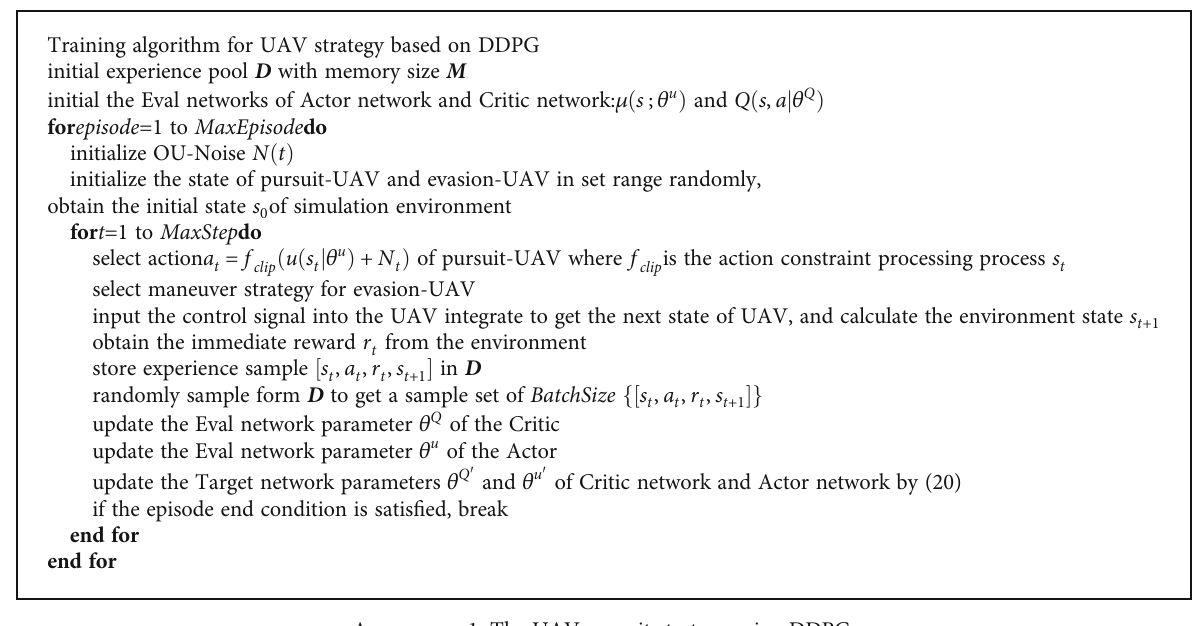
Algorithm 1: The UAV pursuit strategy using